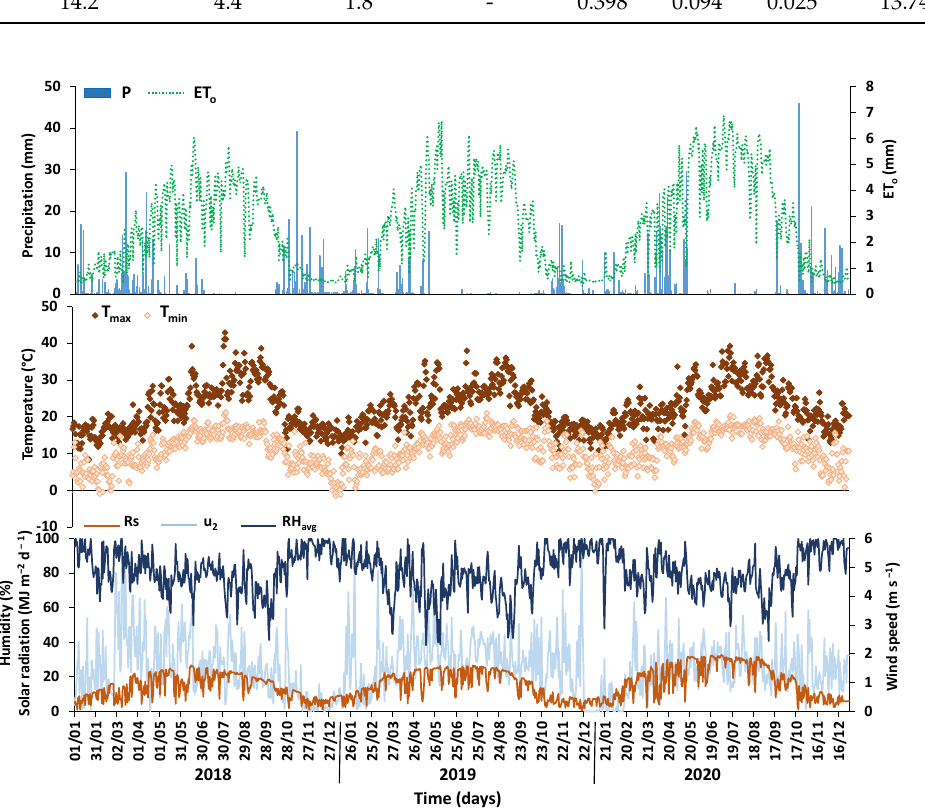
Figure 2. Weather data of Samora Correia case study (P, precipitation, ET o , reference evapotranspiration; T max and T min , maximum and minimum air temperatures; RH avg , mean relative humidity; R s , solar radiation, u 2 , wind speed at 2 m height).